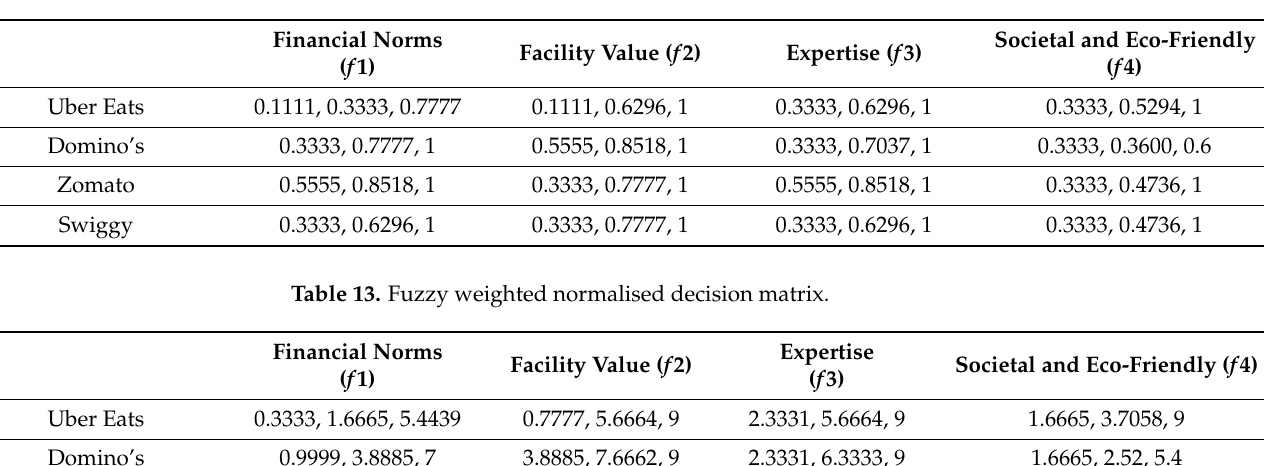
Table 12. Fuzzy normalised decision matrix.